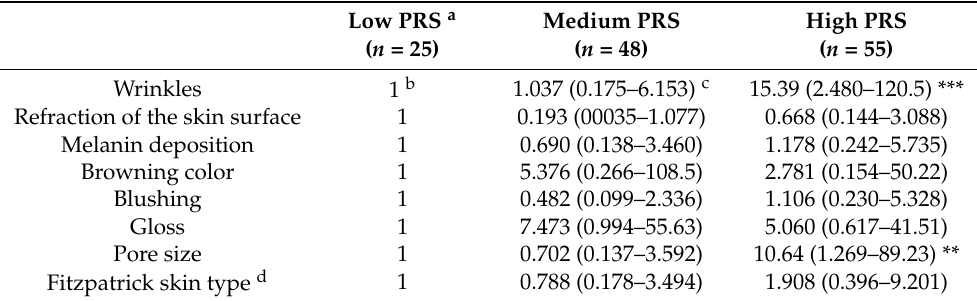
Table 5. Adjusted odds ratios and 95% confidence intervals for skin characteristics according to polygenetic risk scores (PRSs) related to collagen